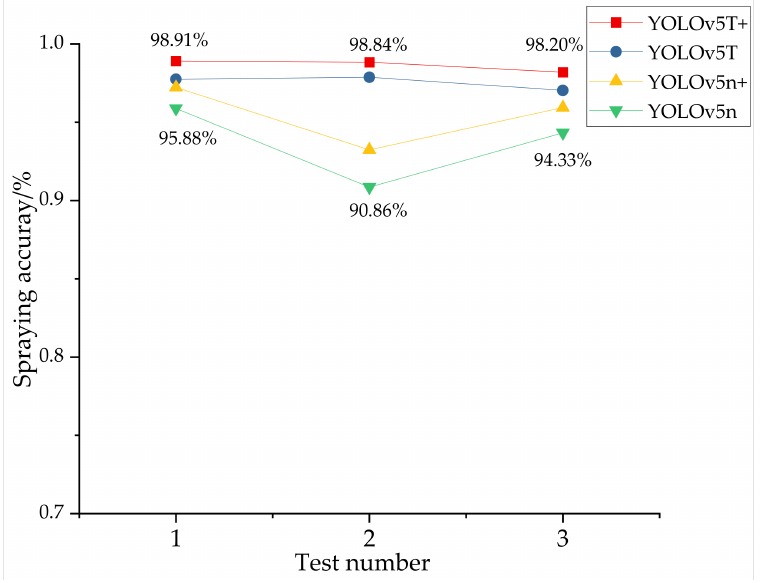
Figure 13. Spraying accuracy for cabbages under different light intensities. Note: YOLOv5T repre- sents the optimized model proposed in this paper, and + represents a model trained on a data set augmented with motion blur.